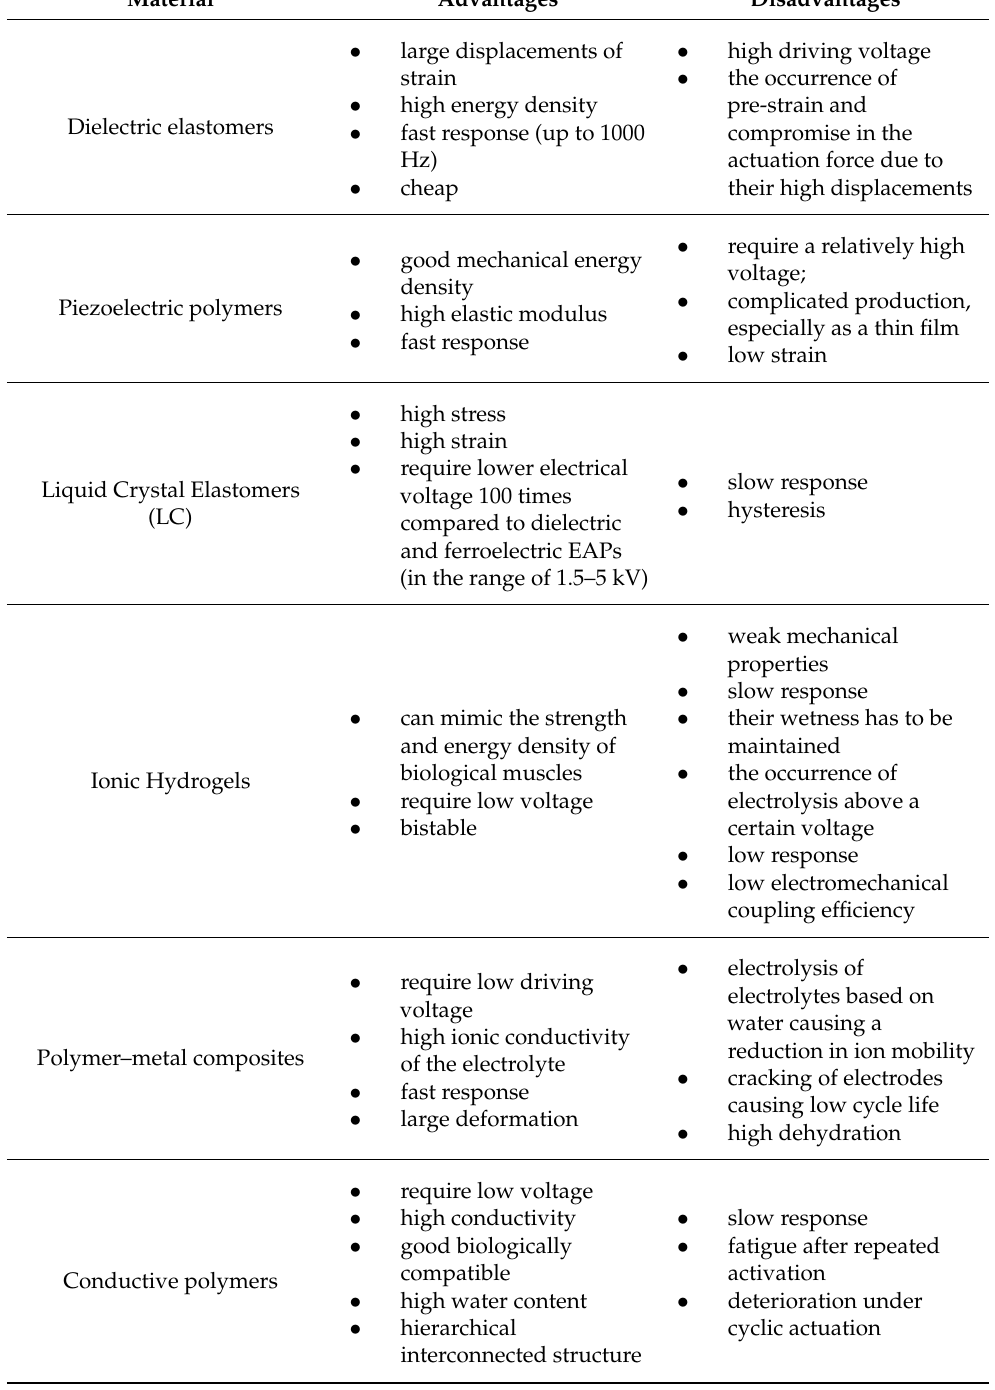
Table 2. Advantages and disadvantages of electroactive polymers